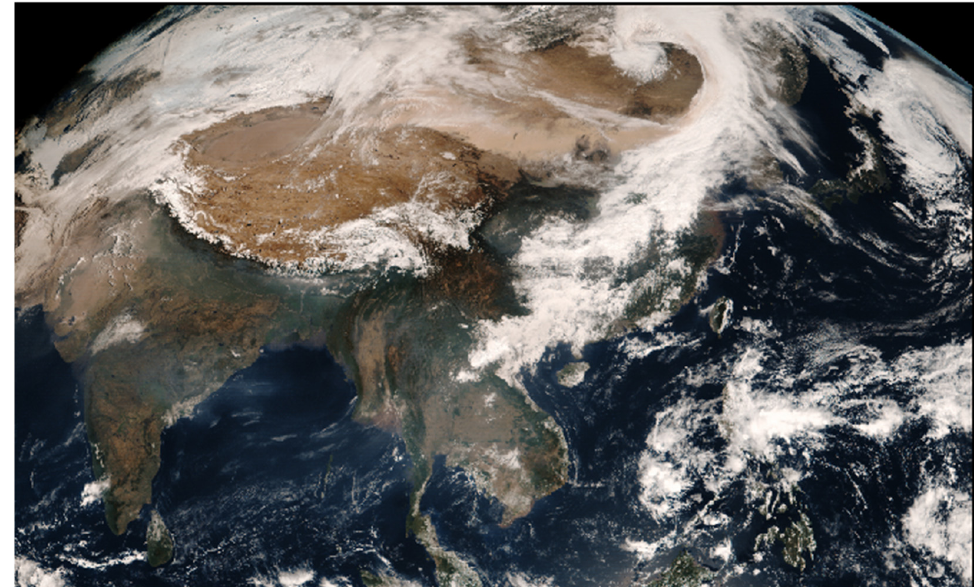
Figure 1. Mongolian cyclone observed by FY-4A on 15 March 2021.